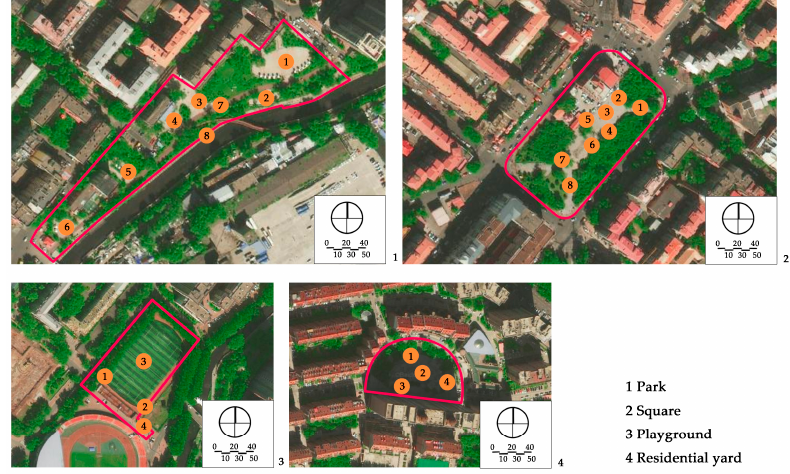
Figure 1. Distribution of the observation sampling sites in each green space.